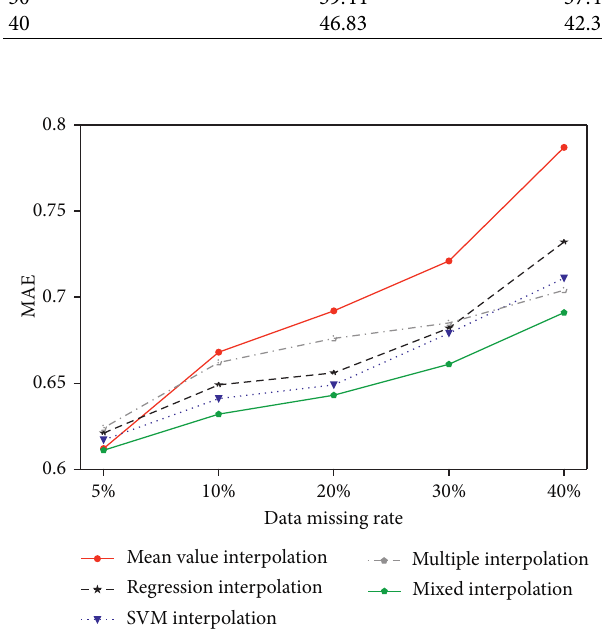
Figure 8: MAE values of the five interpolation methods under different data miss rates.